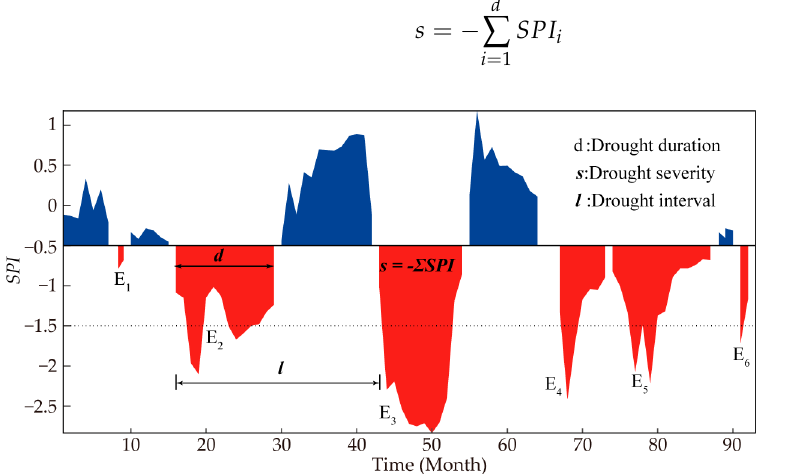
Figure 2. A basic illustration of drought events based on run theory. The red portions indicate drought periods, while the blue portions indicate non-drought periods.